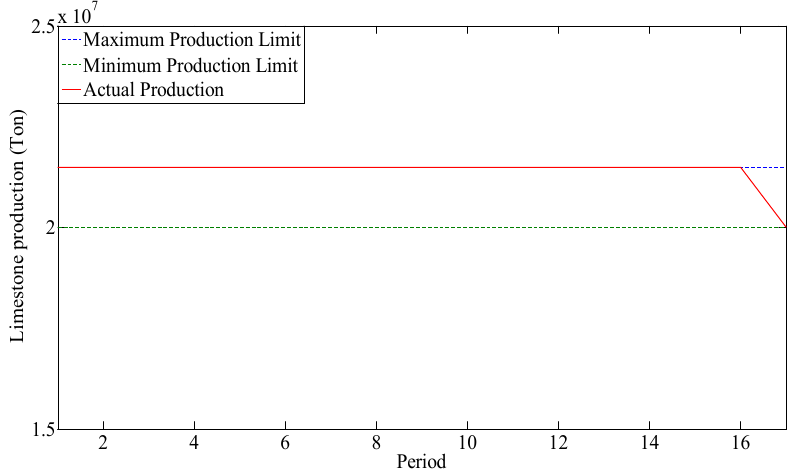
Figure 10. Model 2 Production Periods for Limestone with Production Bounds.